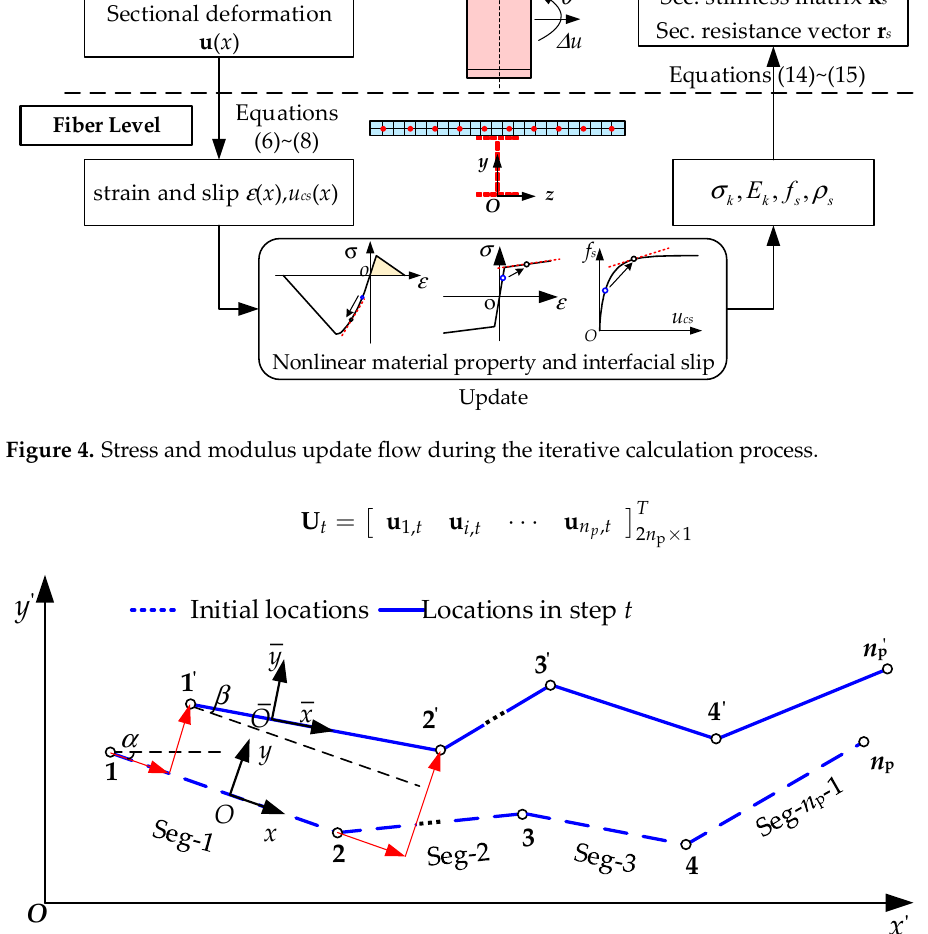
Figure 5. Configuration of the multi-node slipping cable element.